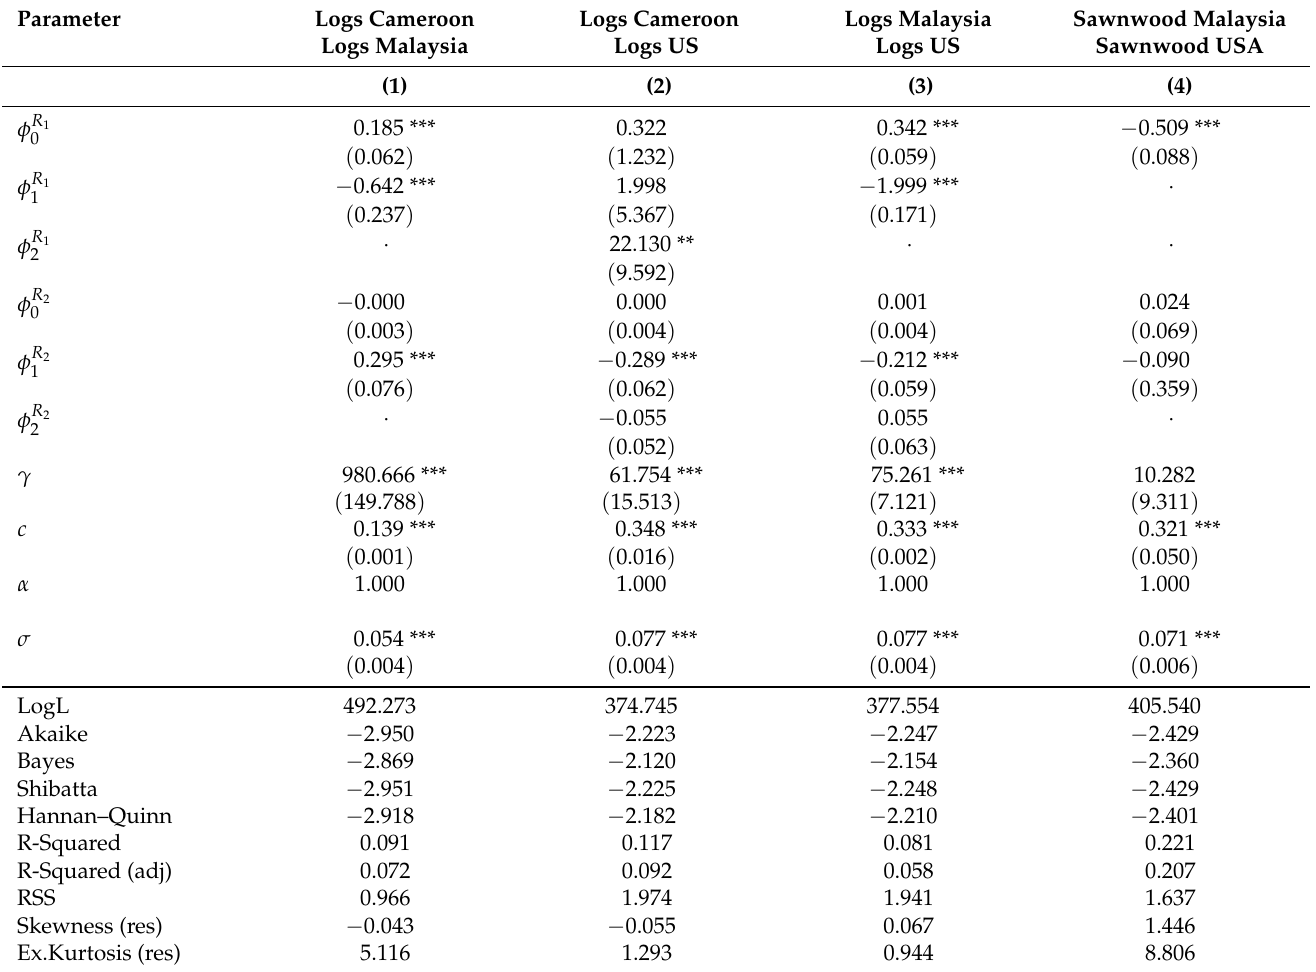
Table 5. Selected SETAR 1 models for forest products price